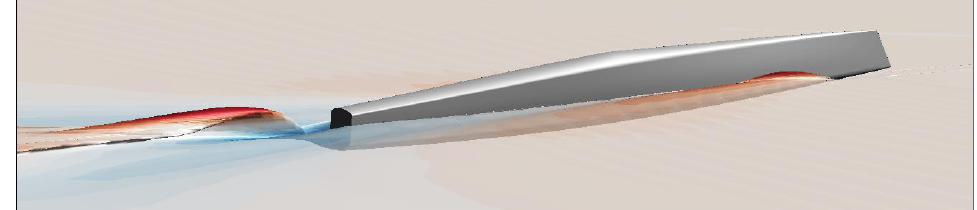
Figure 2. Reference demihull adopted to develop the analytical hull forces model.